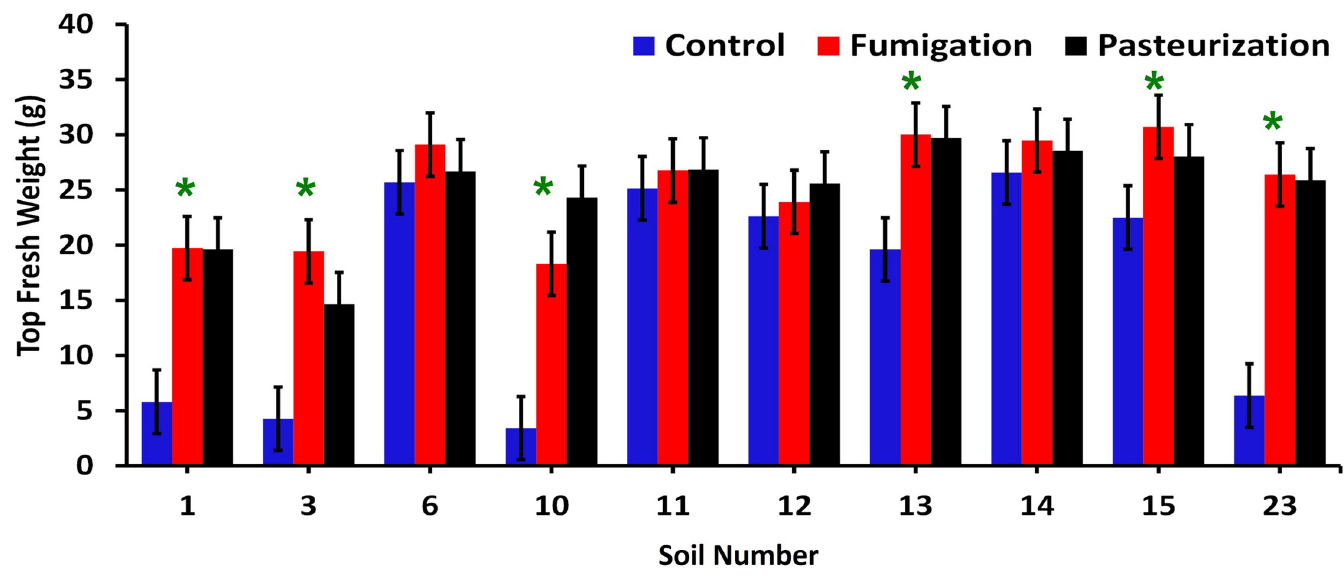
Fig 1. Final top fresh biomass of Nemaguard peach seedlings as a function of soil source and preplant soil treatment in greenhouse bioassay. The weights were affected by significant soil source × soil treatment interaction ( P < 0.0001). Asterisks indicate soils in which mean top fresh weights from fumigated and pasteurized treatments exceeded the weights of the control treatment, according to 95% confidence intervals indicated by error